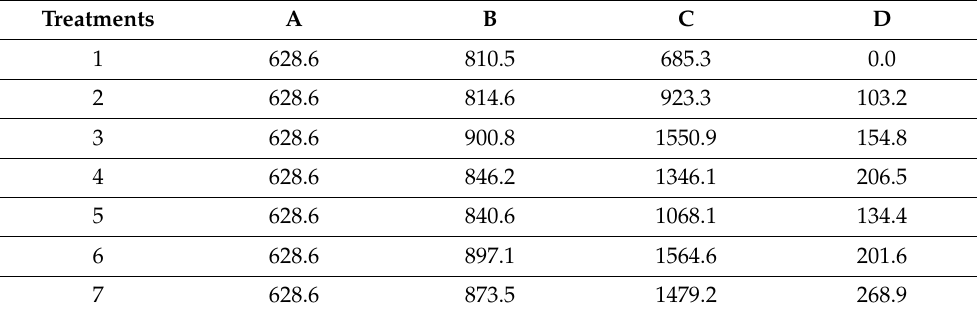
Table 5. CO 2 emissions from fertilizers (CO 2 eq /ha).